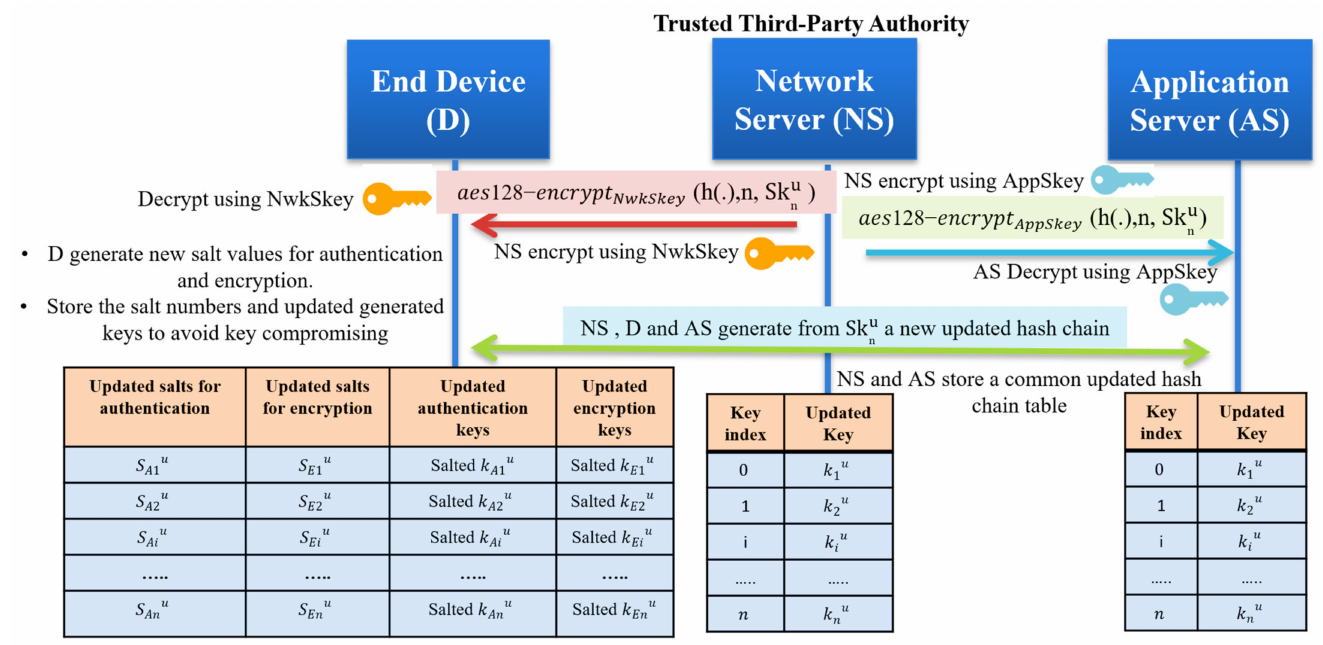
Figure 8. The master secret key update and self-generation of new salted keys for authentication and